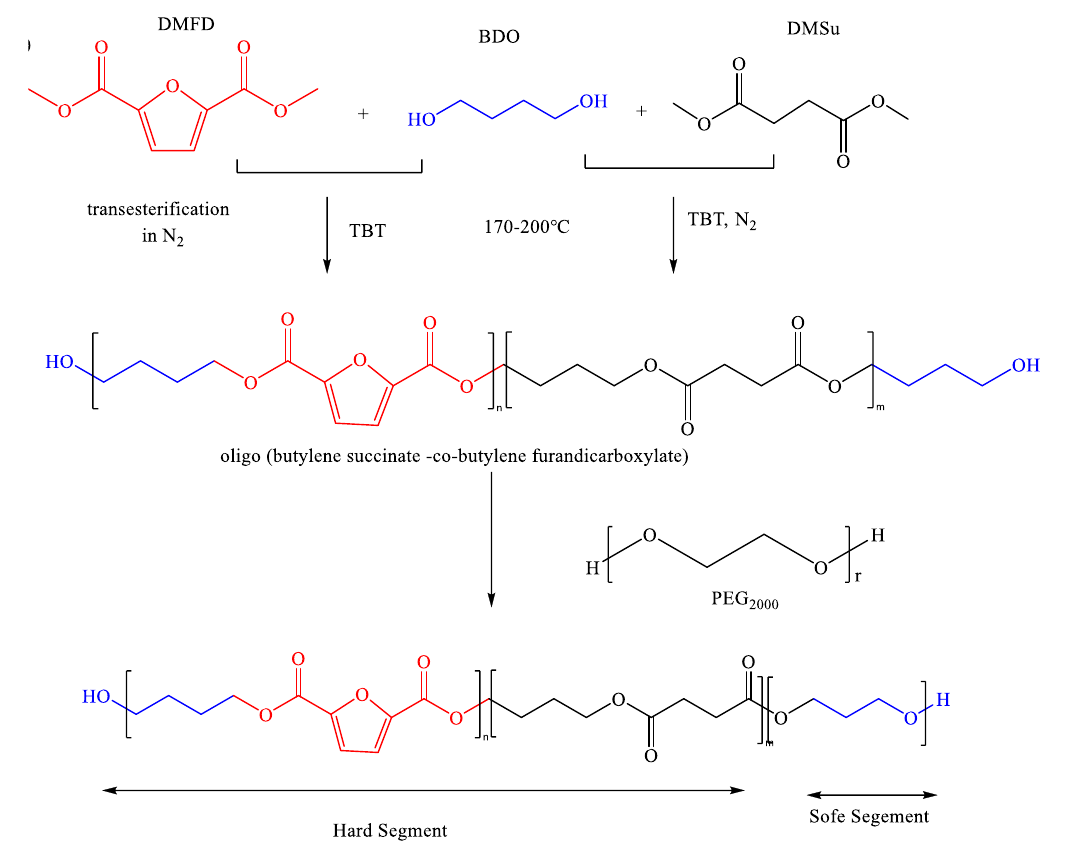
Figure 1. Synthesis process of the PBSF-PEG copolymers.